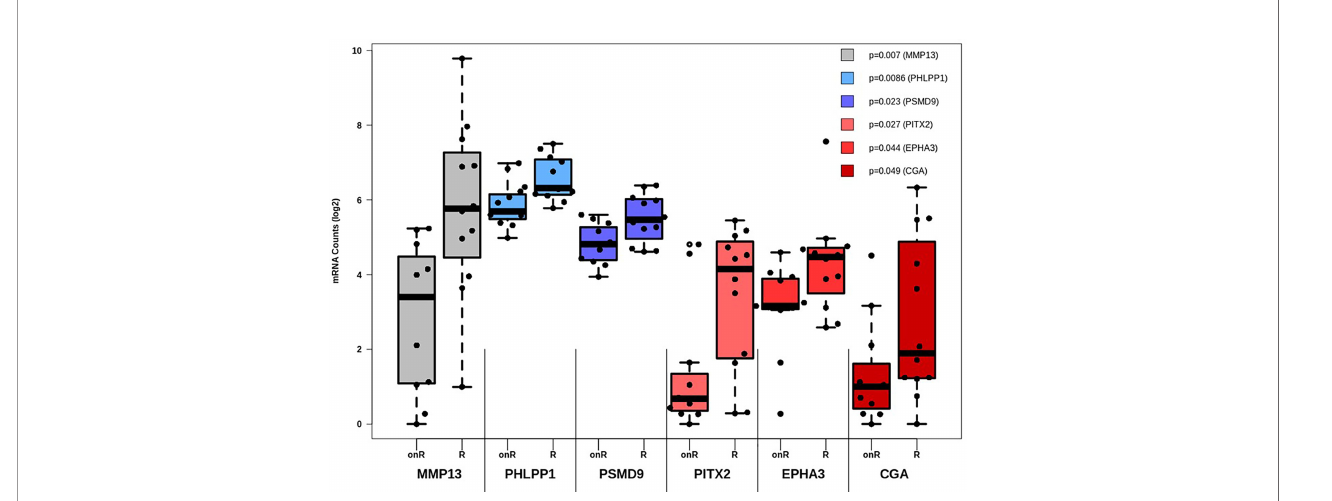
FIGURE 3 | Differential expression analysis of genes affecting therapy outcome. For each gene the number of measured counts were compared between patients still responding to therapy (Ongoing Response, “ onR ” ) or not (Resistant, “ R ” ). Group-based expression differences were visualized by p-value, which was calculated by Wilcoxon Mann-Whitney rank sum